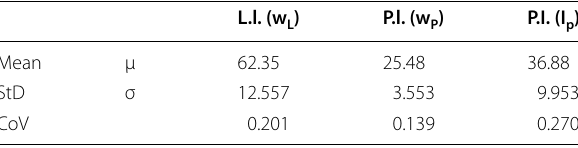
Table 8 Statistical parameters of the Atterberg limits (114